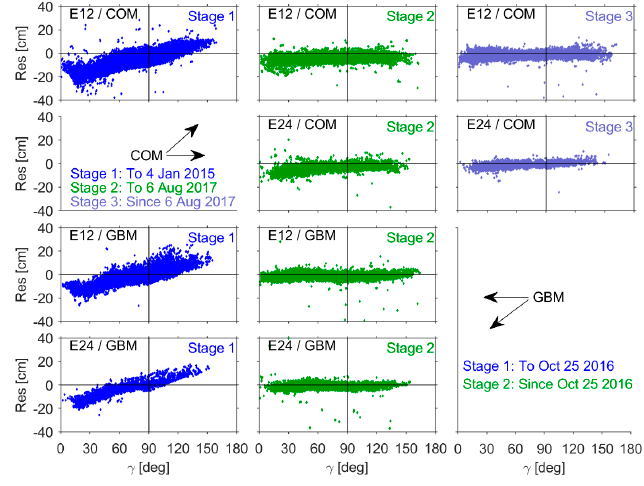
Figure 9. SLR residuals as a function of the Earth–satellite–Sun elongation γ .